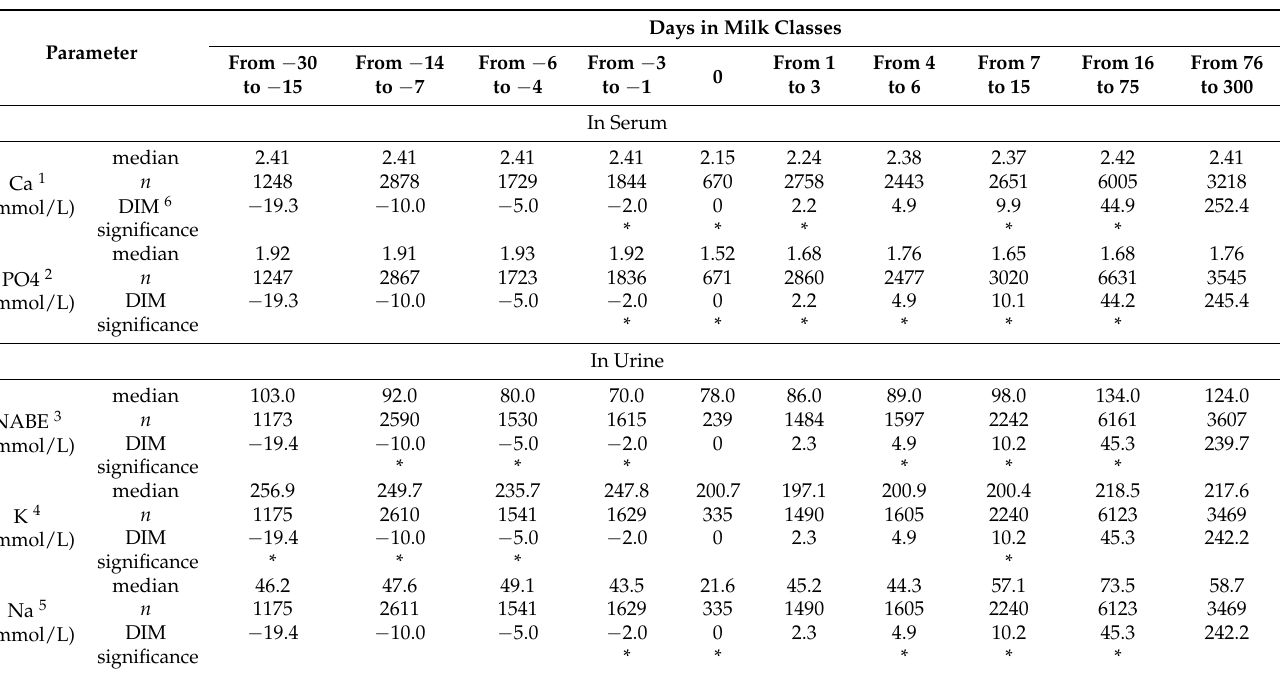
Table A6. Parameters of mineral status and acid base metabolism in serum and urine in ten DIM classes in multiparous